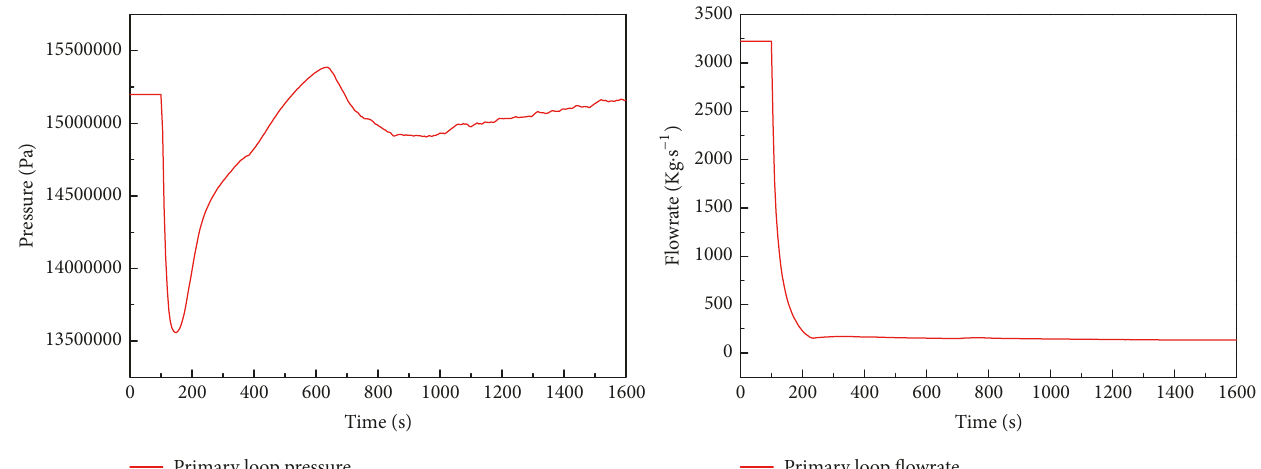
Figure 5: Variations of primary loop pressure and flow rate versus time.